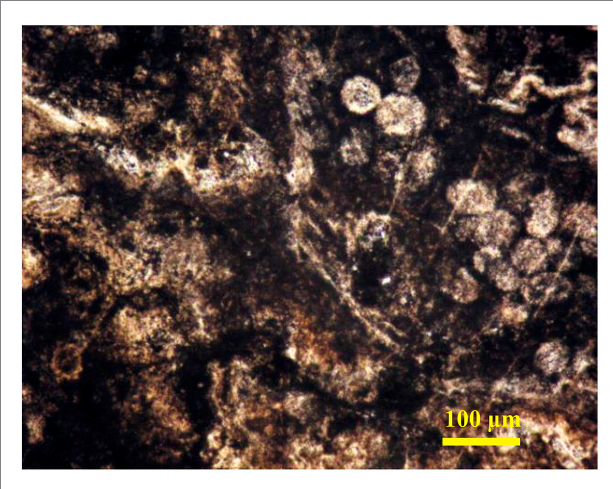
FIGURE 6 – Photomicrograph of sample 2291, detail of photomicrograph sampling circular bioclasts (Morgenstein